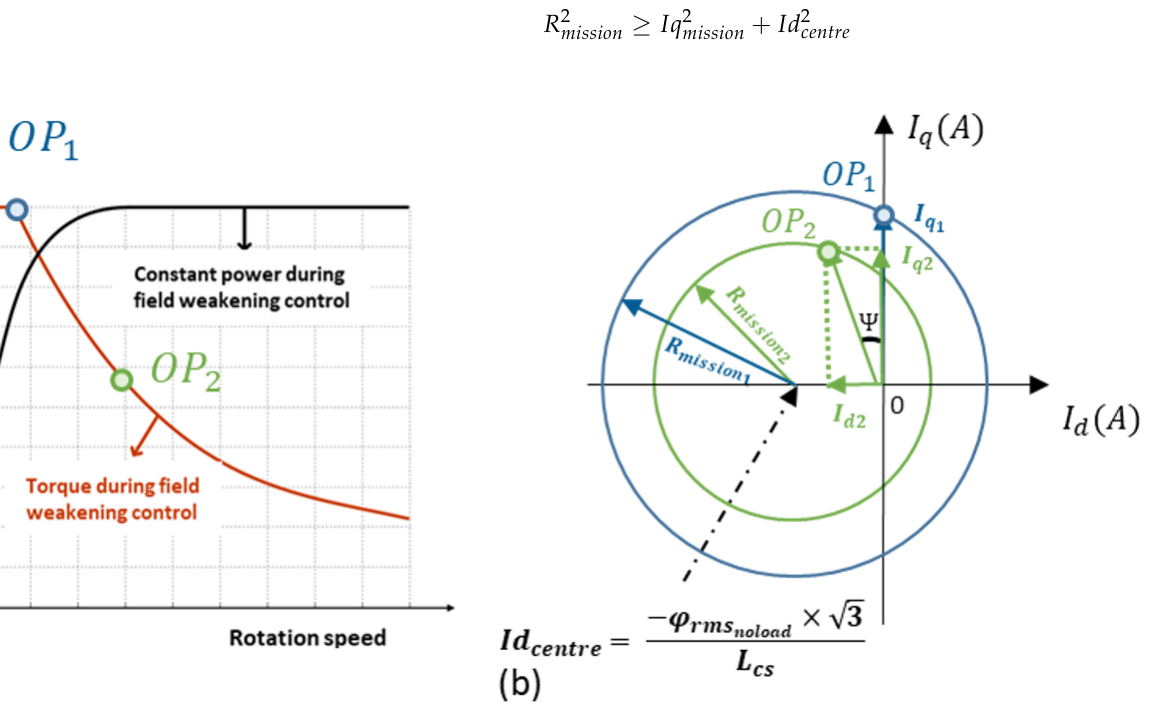
Figure 7. Field-weakening operation. ( a ) Power/torque versus rotational speed plane. ( b ) Analysis in the d - q plane. Two representations of actuator circles (blue circle: maximum torque per ampere strategy, with I d = 0, green circle: field-weakening strategy, with increased speed and constant limited voltage).